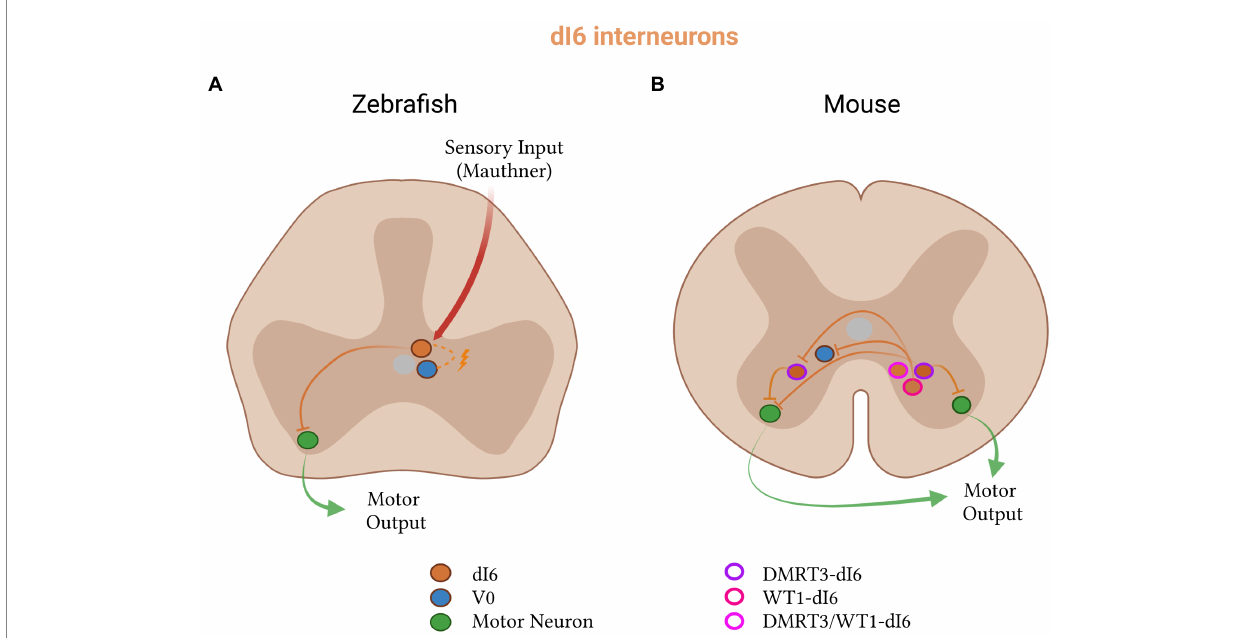
FIGURE 6 Inhibitory dI6 subtypes in zebrafish and mice. (A) In zebrafish, dI6 neurons (orange) receive input from Mauthner cells, form electrical connections with V0 neurons (blue), and project to contralateral motor neurons (green). (B) In mice, dI6 neurons split into three subclasses: DMRT3- (purple outline), WT1- (pink outline), and DMRT3- and WT1-co-expressing (pink-red outline). WT1-dI6 inhibit contralateral V0 and DMRT3-dI6 neurons, while DMRT3- dI6 inhibit motor neurons on both sides of the spinal